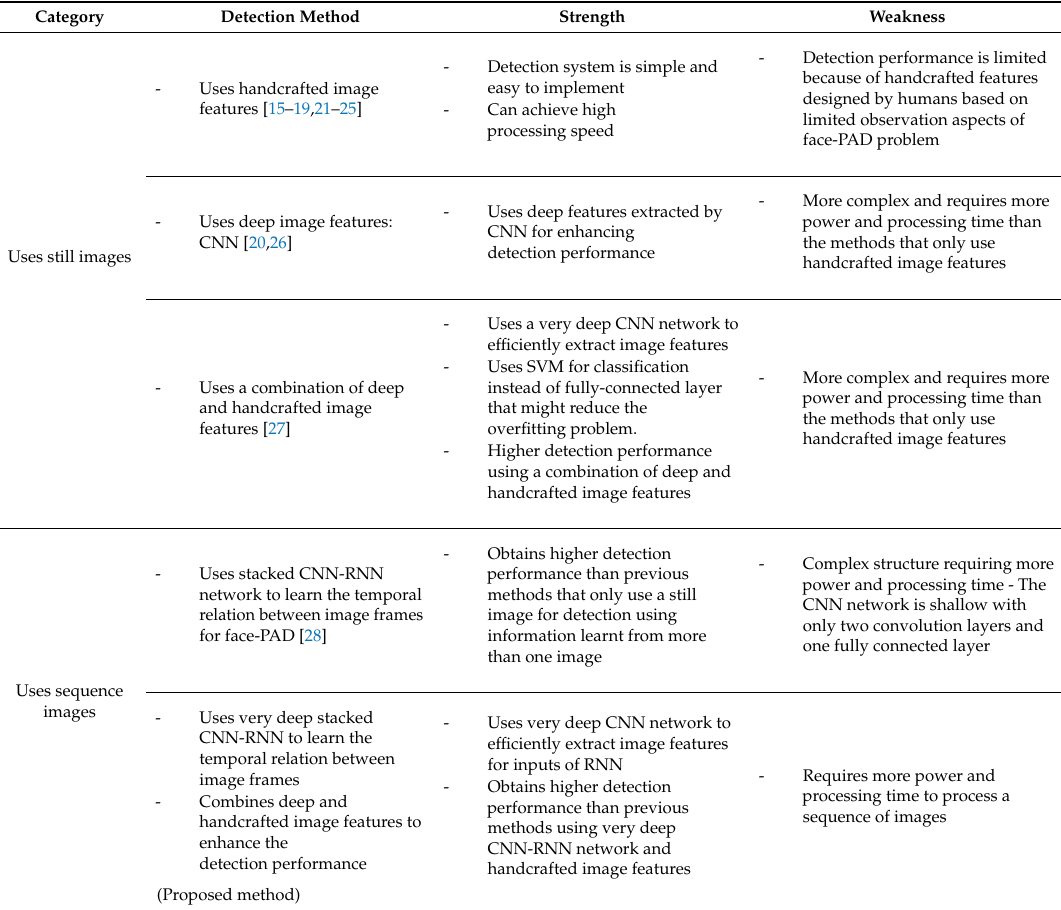
Table 1. A summary of previous studies on face-PAD with comparison with our proposed